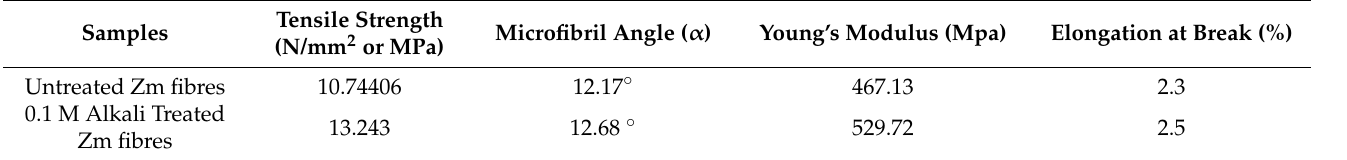
Table 10. Tensile Analysis of Zm